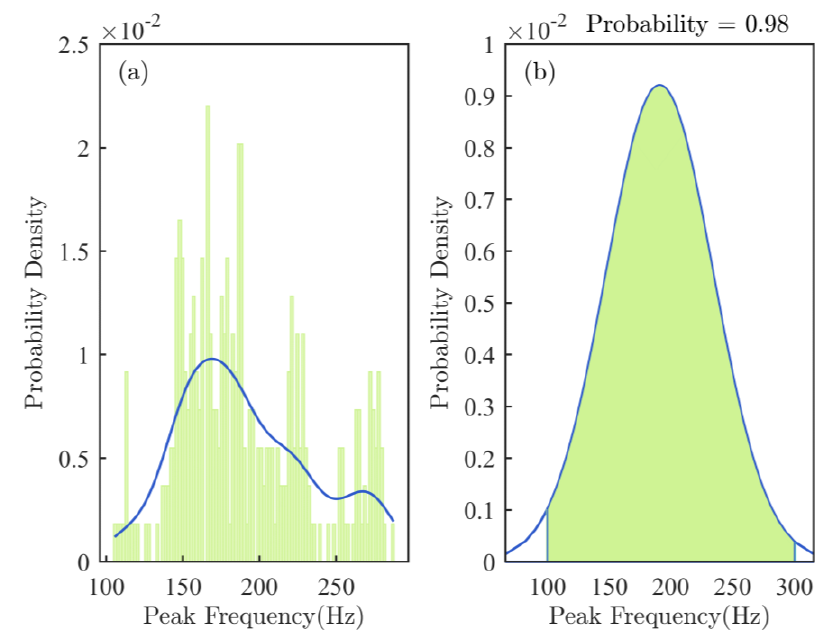
Figure 4. Probability density distribution of the ship engine peak frequency 𝑆𝑓 𝑝𝑒𝑎𝑘 : ( a ) The vertical axis values of the histogram (green part) indicate the probability of the sample falling in each frequency interval, and the blue curve is the probability distribution fitting curve; ( b ) the probability value (shaded green area) calculated using autonomous programming.